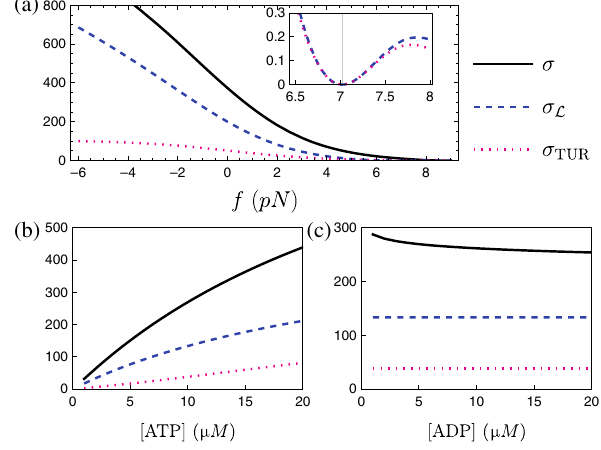
FIG. 11. Exact intertransition-time statistics for the kinesin FIG. 12. Exact analytical values for the rate of entropy model in Fig. 10 with visible transitions 2 ↔ 5 . (a) Intertransi- production for the kinesin model in Fig. 10, with visible tion-time densities for every possible pair of transitions. (b) Kull- transitions 2 ↔ 5 : entropy production σ of the underlying back-Leibler divergence for alternated transitions in terms of the Markov chain (black curves), inferred entropy production from external force f , with the vertical line corresponding to the transition statistics σ L (blue dashed line), and estimate from ∼ 7 . 02 pN. (c) The same as panel (b), but in stalling force of f the thermodynamic uncertainty relation lower bound σ st terms of the ATP concentration. The rates are displayed Table II, (magenta dotted line). (a) Values in terms of the external load and ½ ADP (cid:2) ¼ ½ P (cid:2) ¼ 5 μ M. force f and a zoomed-in view around the stalling force in the inset; for this case, ½ ATP (cid:2) ¼ 10 μ M and ½ ADP (cid:2) ¼ ½ P (cid:2) ¼ 5 μ M. (b) In terms of the concentration of ATP, with f ¼ 1 pN and ½ ADP (cid:2) ¼ ½ P (cid:2) ¼ 5 μ M. (c) In terms of the concentration of ADP, with f ¼ 1 pN , ½ ATP (cid:2) ¼ 10 μ M, and ½ P (cid:2) ¼ 5 μ